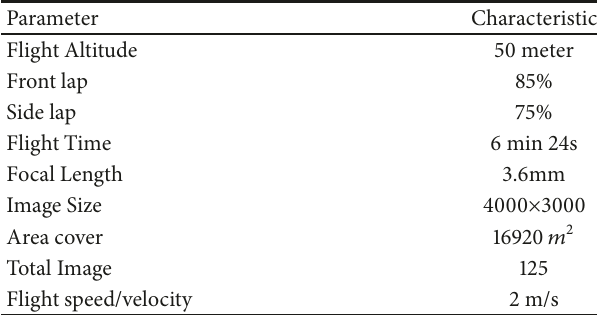
Table 2: Flight planning parameters.